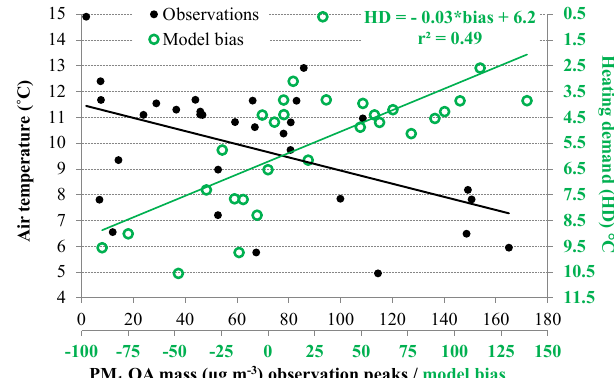
Figure 8. The linear correlation between air temperature ( ◦ C) and submicron organic aerosol concentration peaks (PM 1 OA in µgm − 3 , in black) and between the heating demand (HD, in ◦ C) and the model bias (for PM 1 OA in µgm − 3 , in green). All data refer to the Thissio site